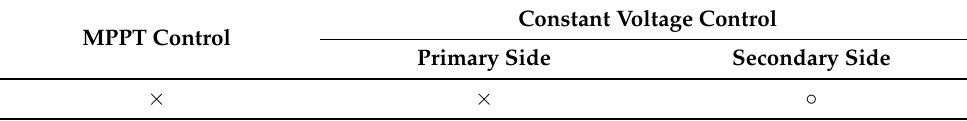
Table 2. Stability of PV-VSM for each DC-side control strategy. ◦ means stable result and × means unstable